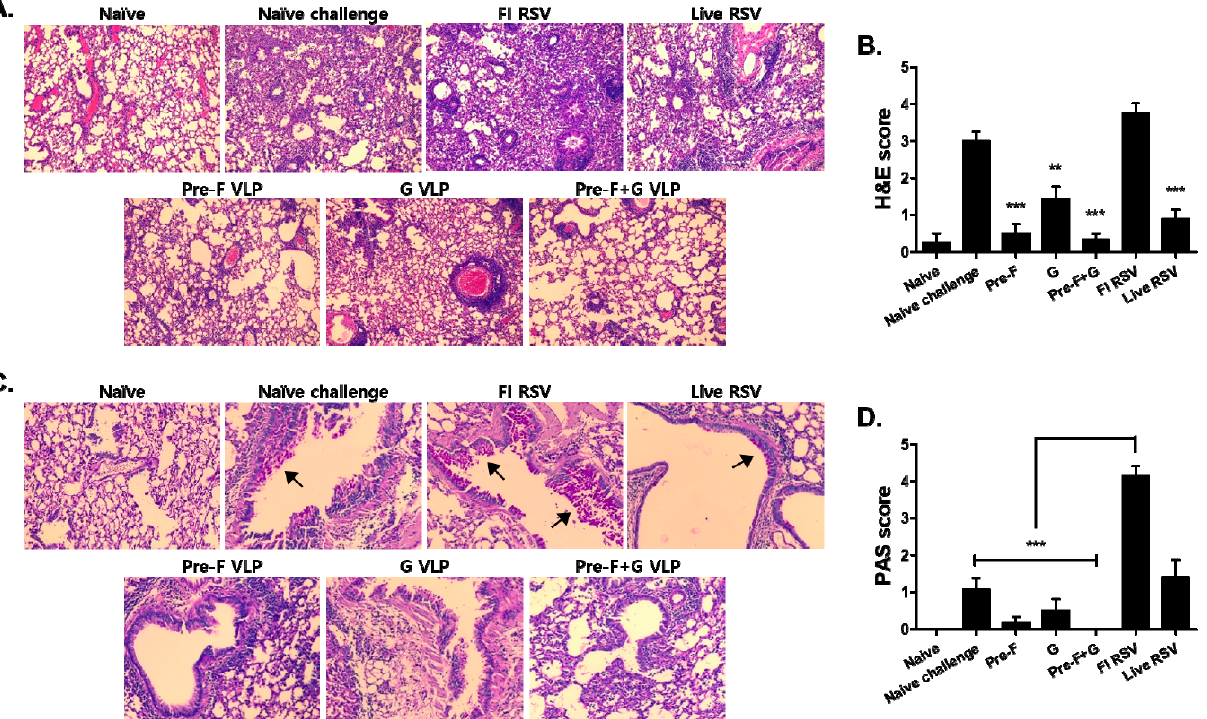
Figure 6. Lung pathology assessment. Lung tissues (n = 3) were collected from individual mice at day 5 post-challenge, and the micro-sectioned tissues were stained with hematoxylin and eosin (H&E) and periodic acid–Schiff (PAS) to observe pathological changes in the lungs. H&E staining ( A ) and H&E pathology scores ( B ) for inflammation were determined. PAS staining ( C ) and its corresponding score ( D ) for mucin production were determined. Magenta-stained areas show mucin production and these were indicated using arrows. VLP-immunized mice showed lower cellular influx compared to naïve challenge (( B ), ** p < 0.01, *** p < 0.001). VLP-immunized mice showed significantly lower PAS scores than the FI-RSV group (( D ), *** p < 0.001). All images were acquired at 200× magnification.